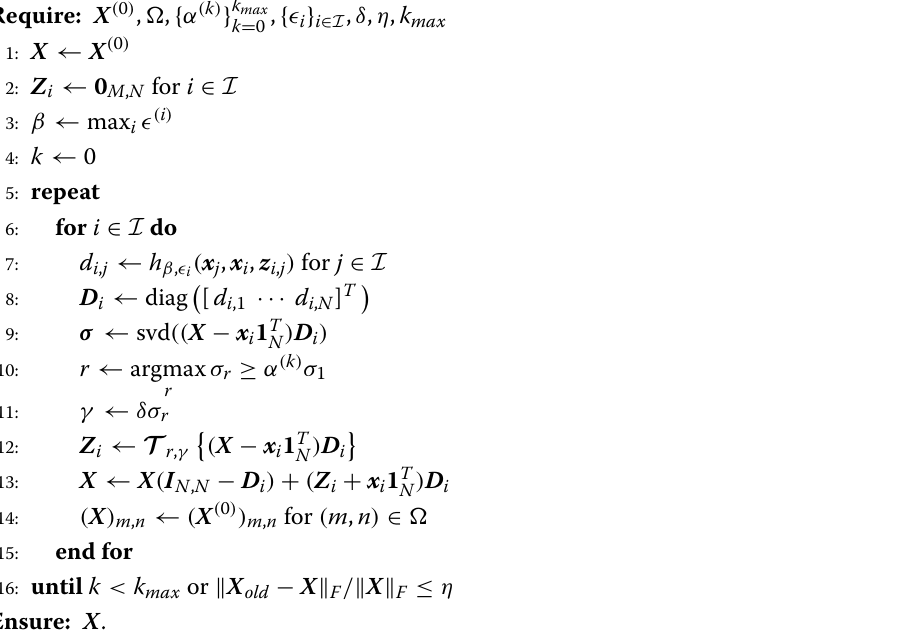
Algorithm 2 LLRA using a stochastic-gradient-descent-like algorithm